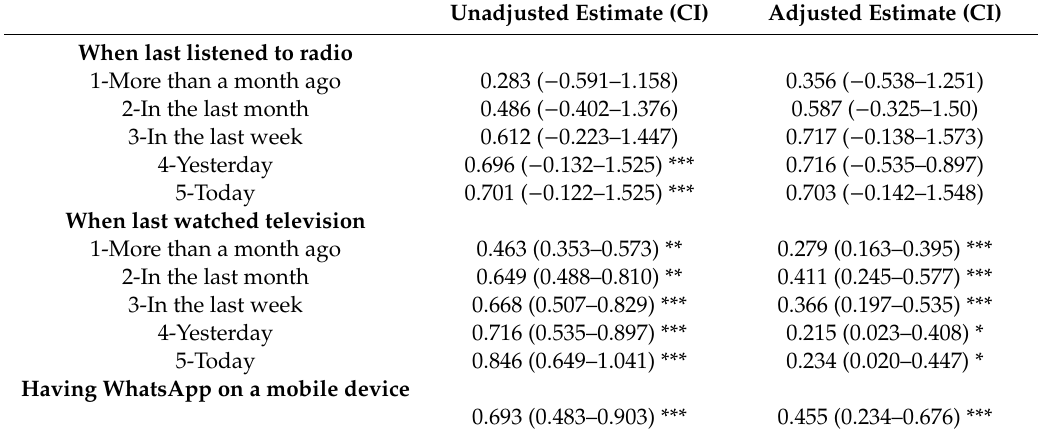
Table 3. When to wash hands knowledge indicators associated with media access.